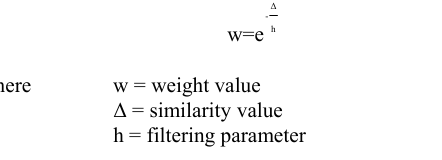
parameter. The red curve and blue curve in Figure 6 are the PDFs of similarity values calculated from the heterogeneous area and the homogeneous area, respectively. These two curves have an intersection point T. On the left side of point T, the